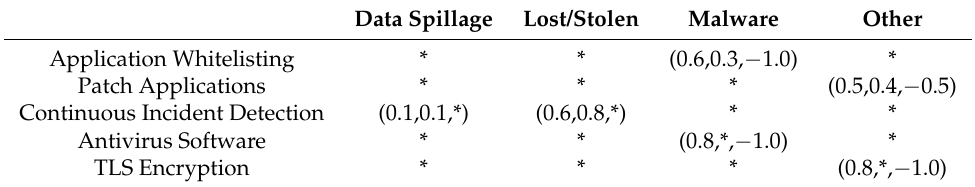
Table 5. Values of a mj , b mj ∈ [ 0,1 ] and c mj ≤ 0, each entry gives a triple ( a mj , b mj , c mj ) . A entry of ∗ means a default entry of ( 1,1, 0 ) , meaning the mitigation has no effect on that attack type. Entries of